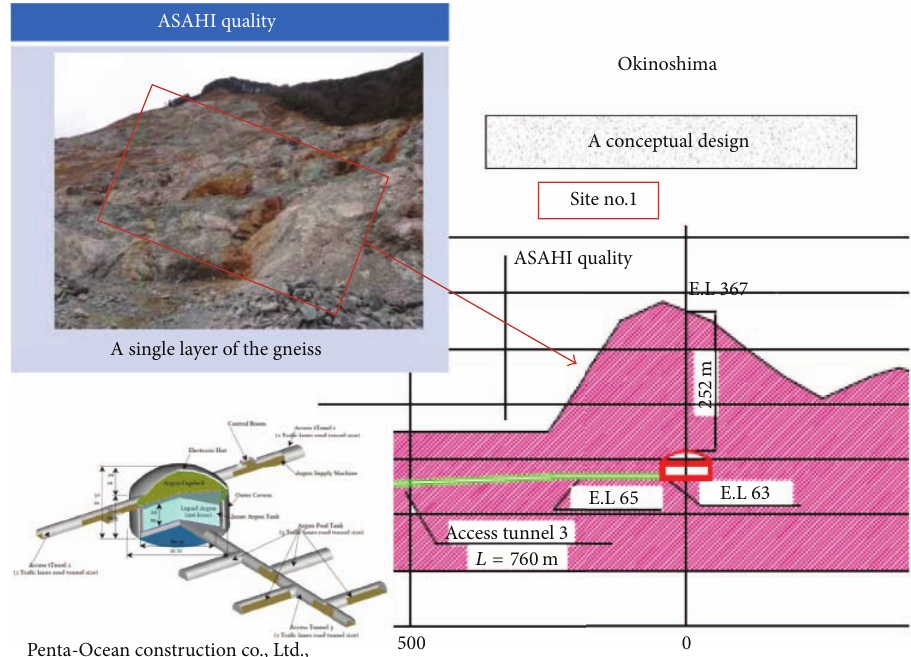
Figure 14: Potential cavern for Okinoshima Giant Liquid Argon Observatory.